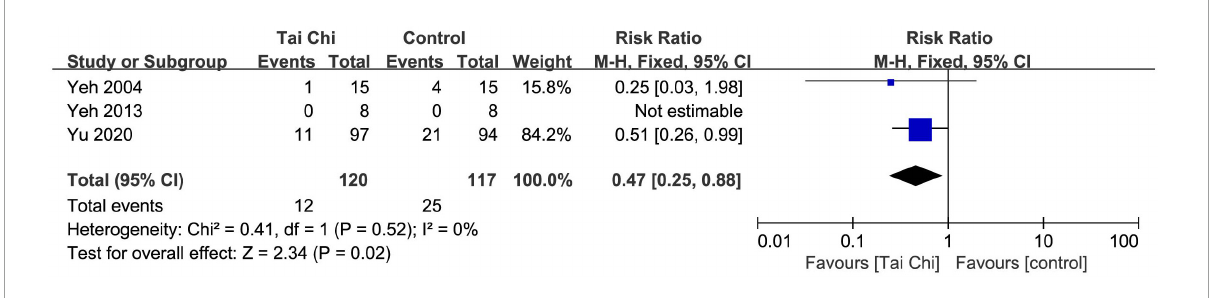
FIGURE11 Meta-analysis of heart failure hospitalization in the Tai Chi group vs. the control group. CI, confidence interval.